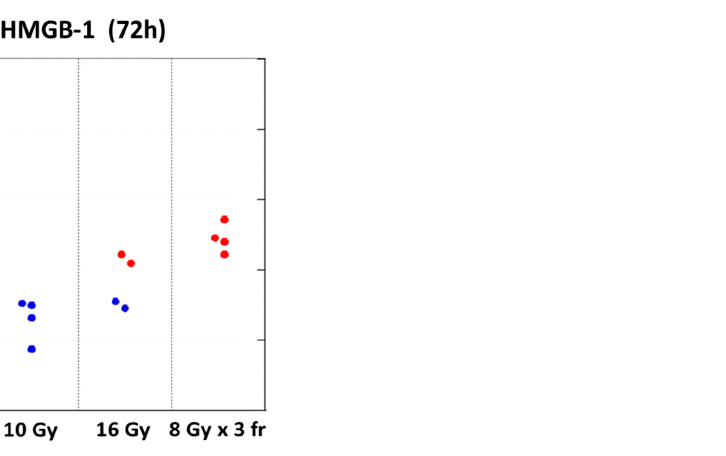
Figure 2. Release of HMGB-1 at 0 Gy (N = 4), 10 Gy (N = 4), 16 Gy (N = 4), and 8 Gy × 3 fr (N = 4). Blue circles represent data below the detection level in the ELISA kit. Abbreviations—HMGB-1: high mobility group box-1; fr: fraction.